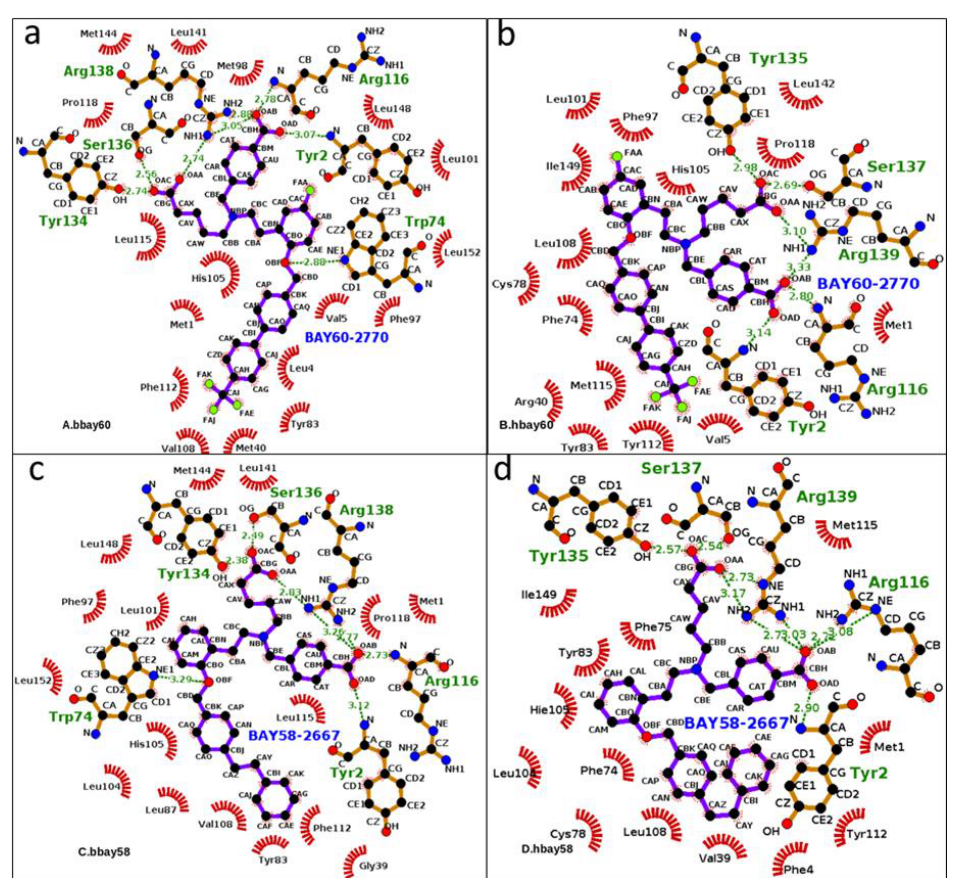
Figure 3. From a to d , 2D graphical outlay of binding modes of sGC activators bound in the binding pockets of human and bacterial H-NOX domains (bbay60, hbay60, bbay58, hbay58). The energy minimized starting structures (hbay58 and hbay60) along with bbay58 and bbay60 (crystal structures) were subjected to MD production phase. Green dotted lines represent Hydrogen bonds whereas hydrophobic interactions are shown by red archs, the ligand atoms are shown in blue and black ball and stick model whereas protein atoms are shown in brown (stick) and black (ball). Aliphatic and aromatic carboxyl groups atoms of activators (OAA, AAB, OAC, OAD) exhibited prominent hydrogen bond interaction with functionally critical residues such as Y2, R116, Y135, S137, R139 in h H-NOX andY2, W74, R116, Y134, S136, R138 in b H-NOX.